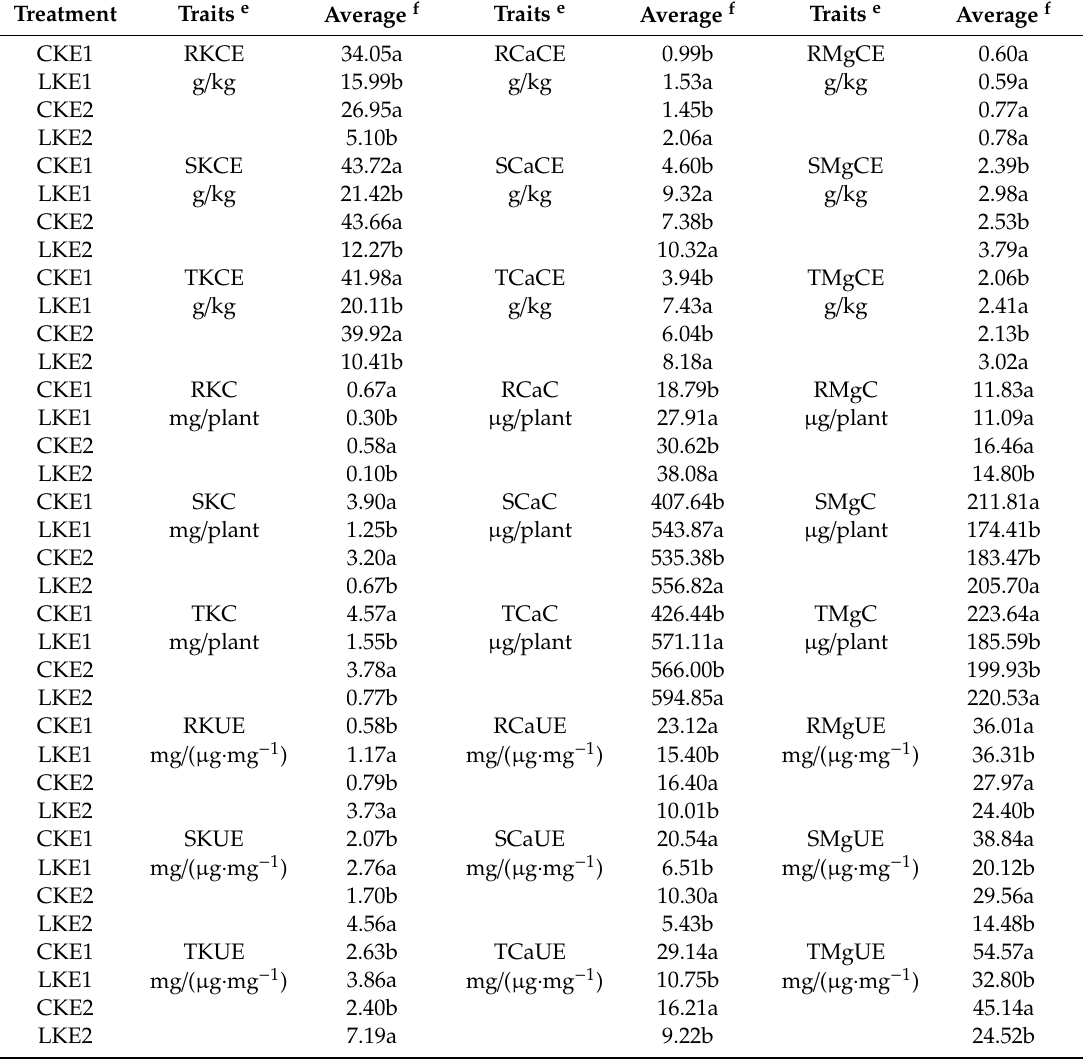
Table 2. Average values for the RILs for each treatment and trait of the hydroponic trial.